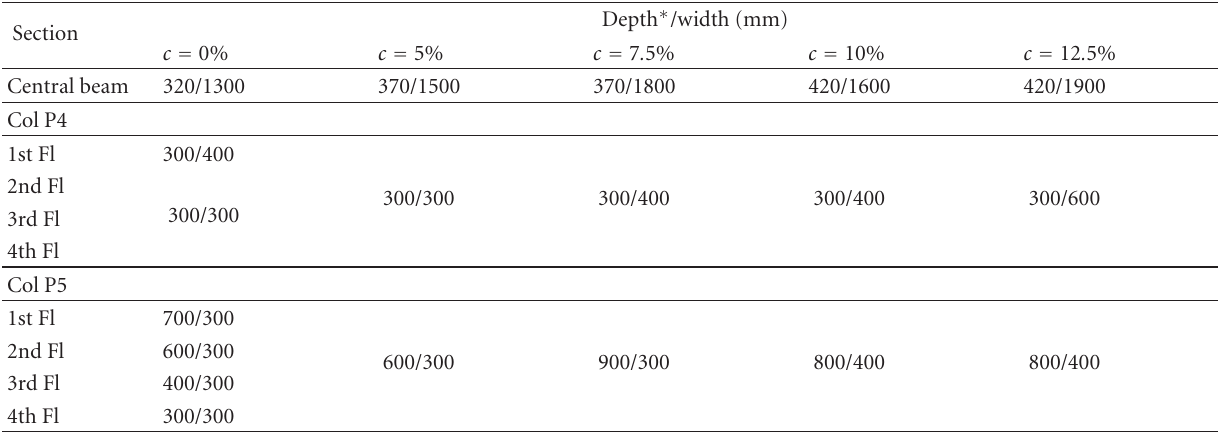
Table 1: Geometrical properties of the central frame of the prototype building in Figure 3 designed to di ff erent proportions of lateral load ( c ).